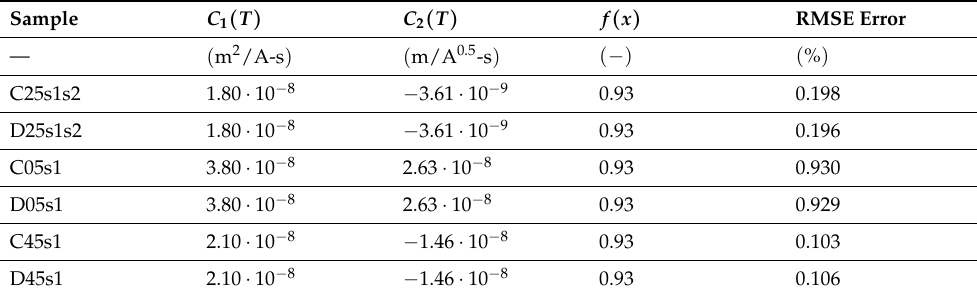
Table 10. Second adjustment of the parameters C 1 ( T ) and C 2 ( T ) to fit the experimental data at temperatures 25, 5 and 45 ◦ C.